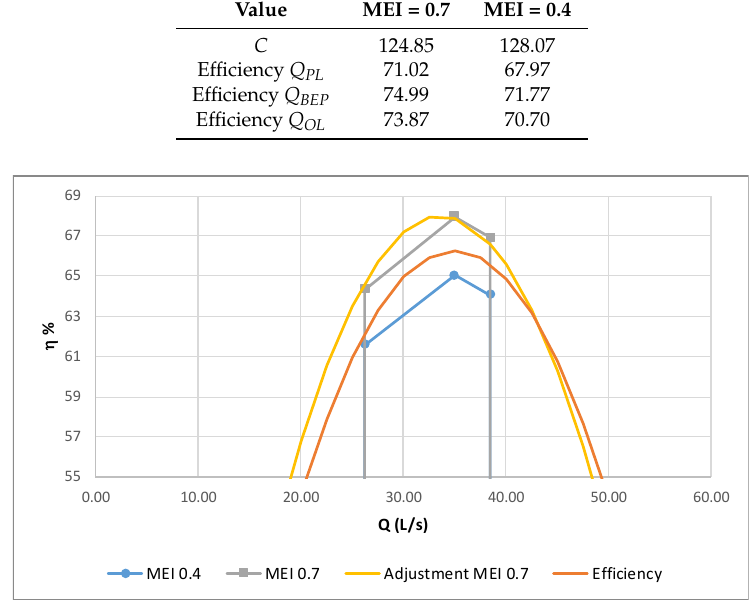
Figure 8. Comparison of working pumps and new pumps (MEI 0.4 and MEI 0.7).